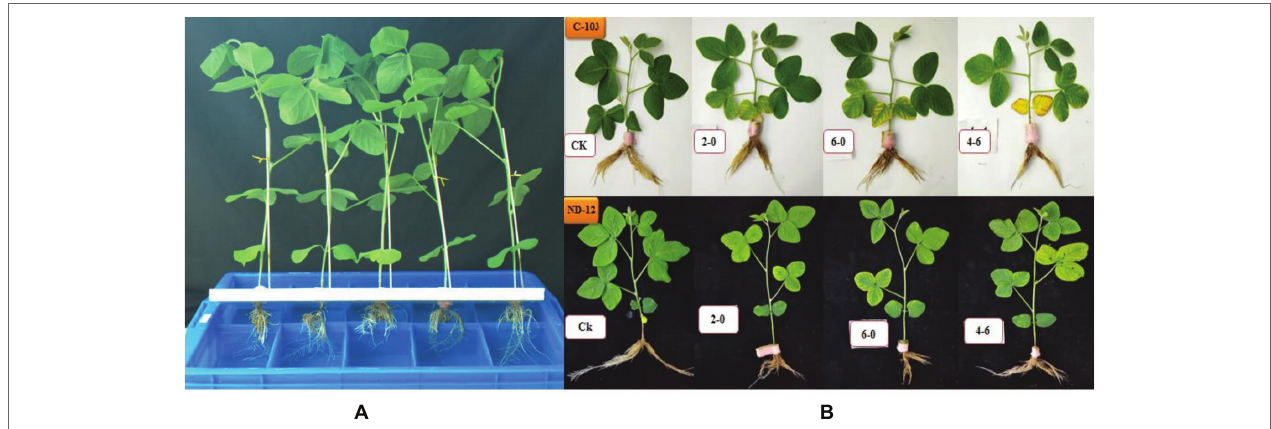
FIGURE 1 | (A) Schematic representation of equally divided soybean roots in the solution box. (B) Phenotypic appearance of soybean cultivars after 5 days of PEG treatments; C-103 with a white background and ND-12 with a black